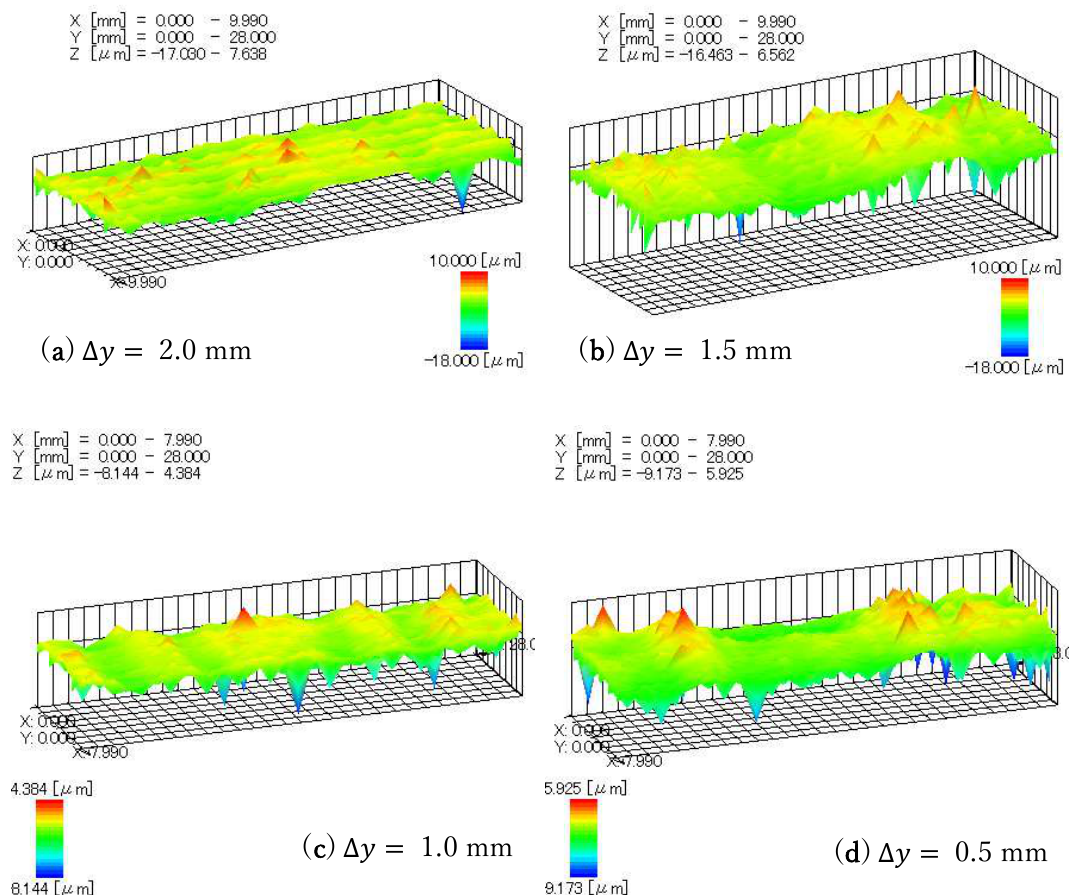
Figure 16. Three-dimensional figures of the processed surface: ( a ) The 3D figure after processing at ∆y = 2.0 mm; ( b ) The 3D figure after processing at ∆y = 1.5 mm; ( c ) The 3D figure after processing at ∆y = 1.0 mm; ( d ) The 3D figure after processing at ∆y = 0.5 mm.